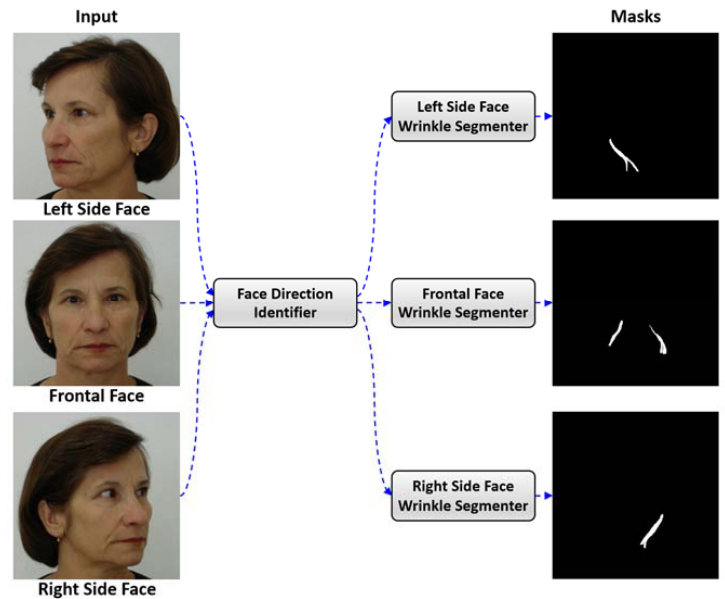
Figure 9. Applying face direction ‐ specific segmentation